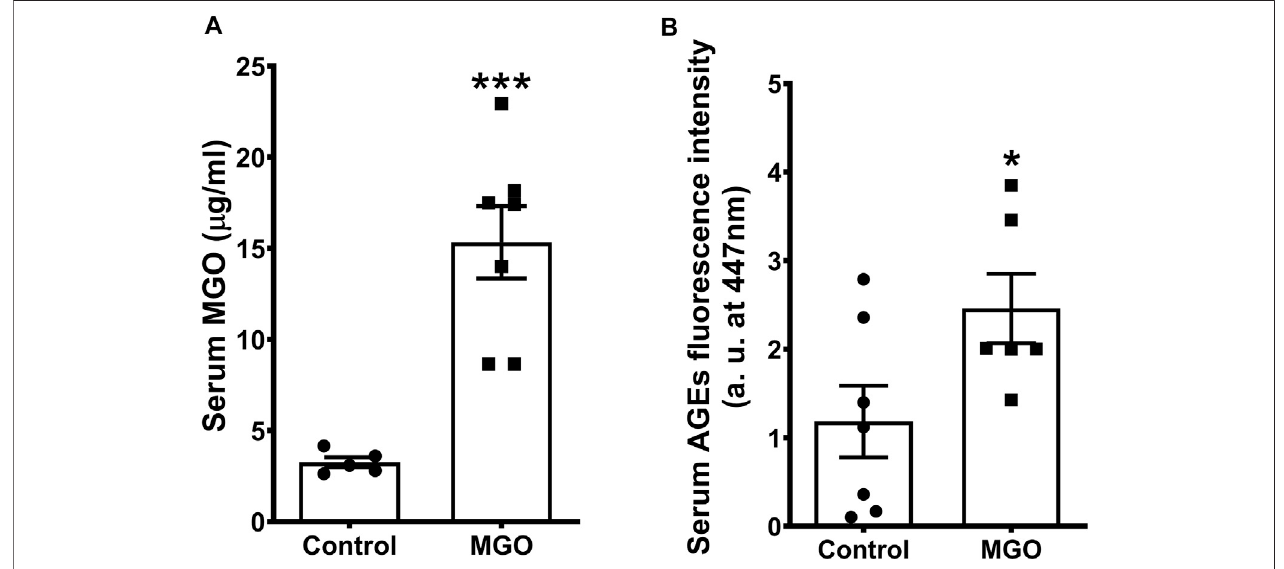
FIGURE 1 | Serum levels of methylglyoxal (MGO) (A) and fl uorescent advanced glycation end products (F-AGEs (B) in mice receiving or not 0.5% MGO for 12 weeks in the drinking water. Data are expressed as mean ± SEM ( n = 5 − 7). * p < 0.05, *** p < 0.001 compared with control group (unpaired t -test).